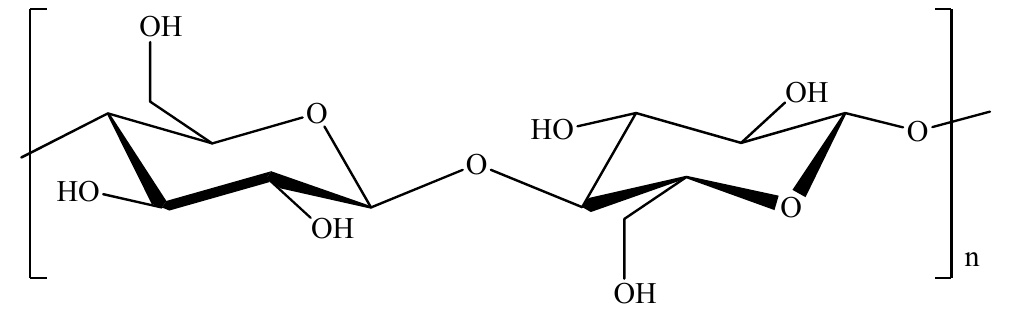
Figure 3. Chemical structure of cellulose.